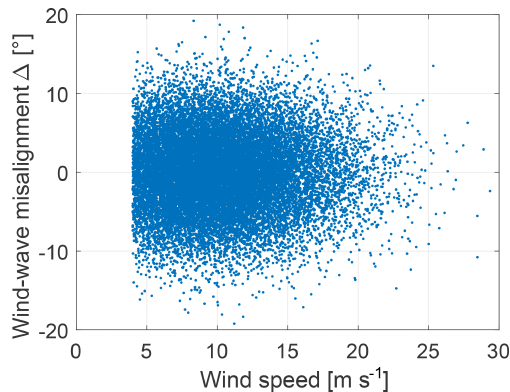
Figure 13. Sampled wind wave